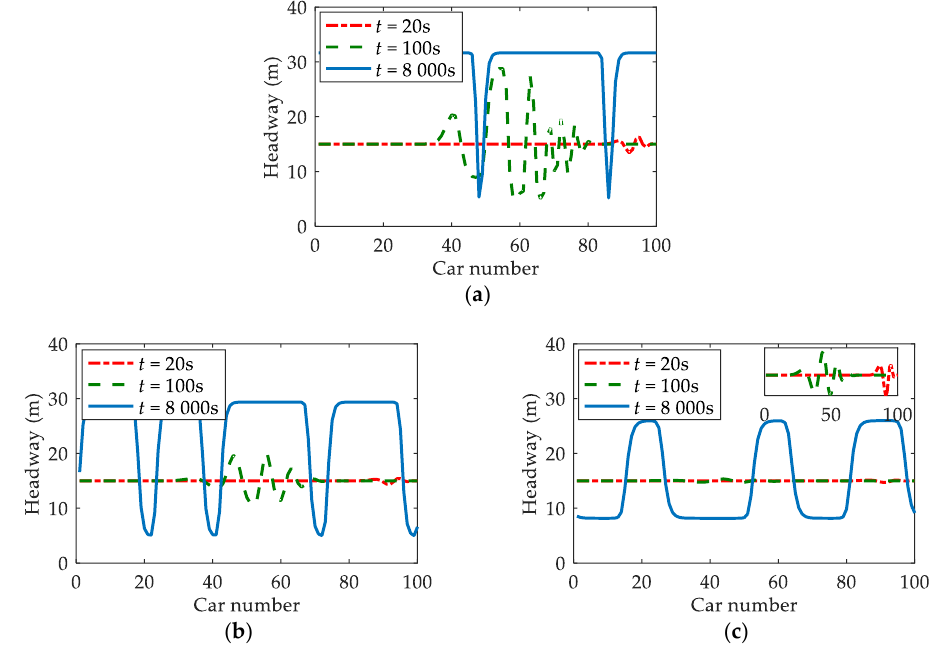
Figure 3. The headway evolutions under different β : ( a ) β = 0; ( b ) β = 0.4; ( c ) when t = 20 s, t = 100 s, and t = 8000 s, where α = 0.2, T = 1.2 s.